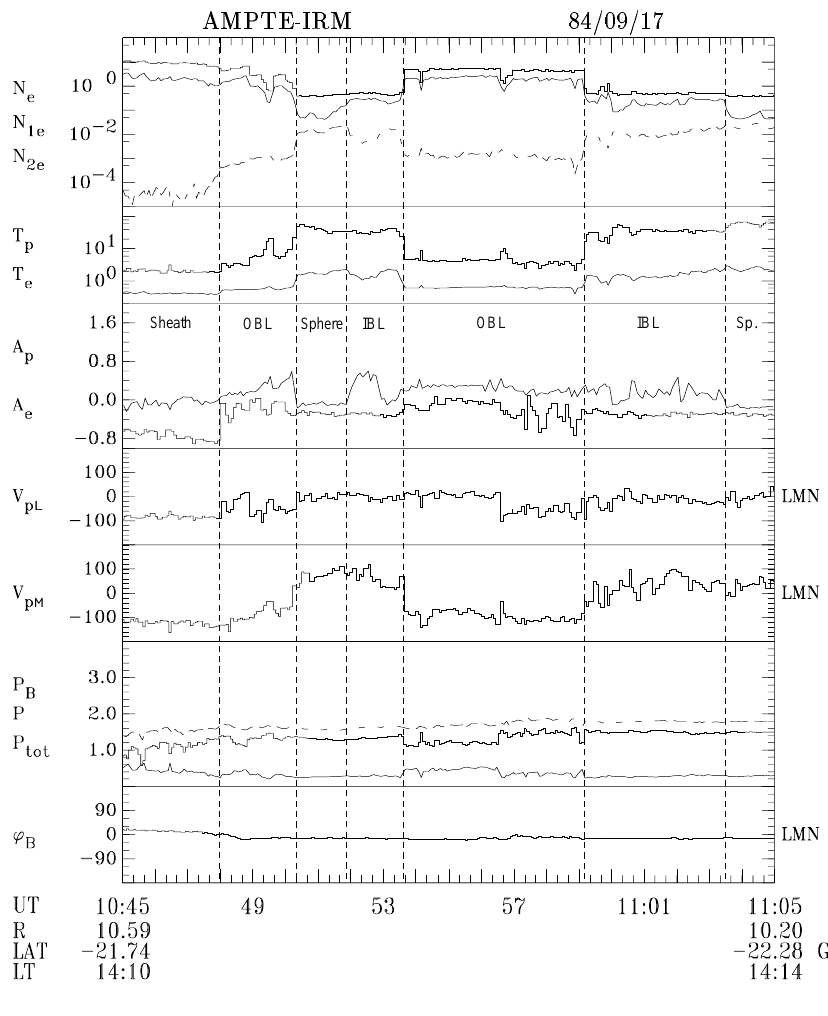
Fig. 6. Overview of the magnetopause pass on 17 September 1984. The format is the same as in Fig.